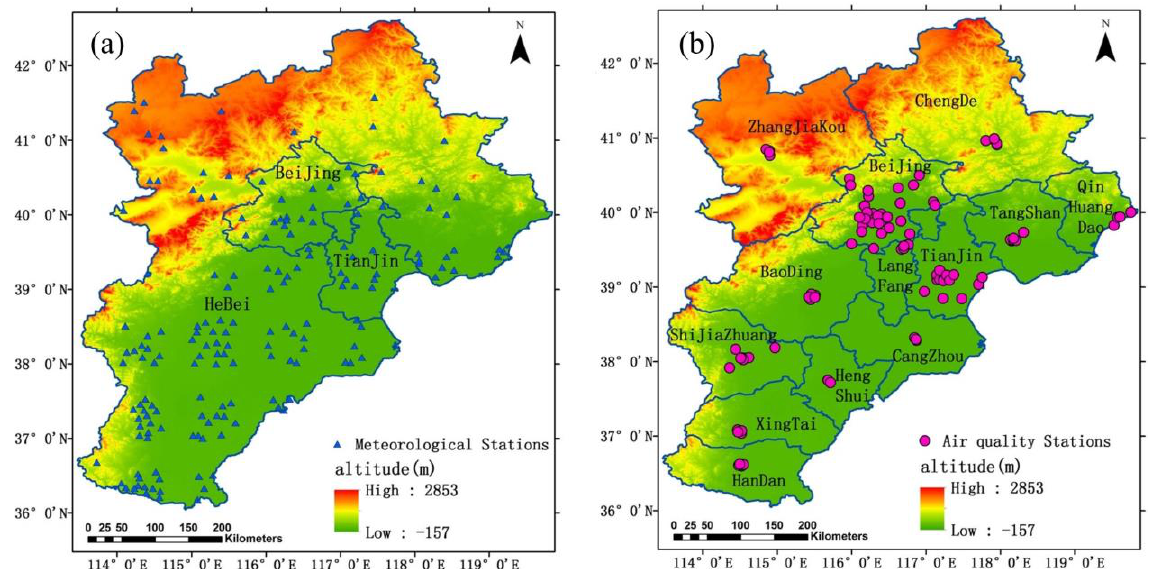
Figure 1 . Schematic diagram of study